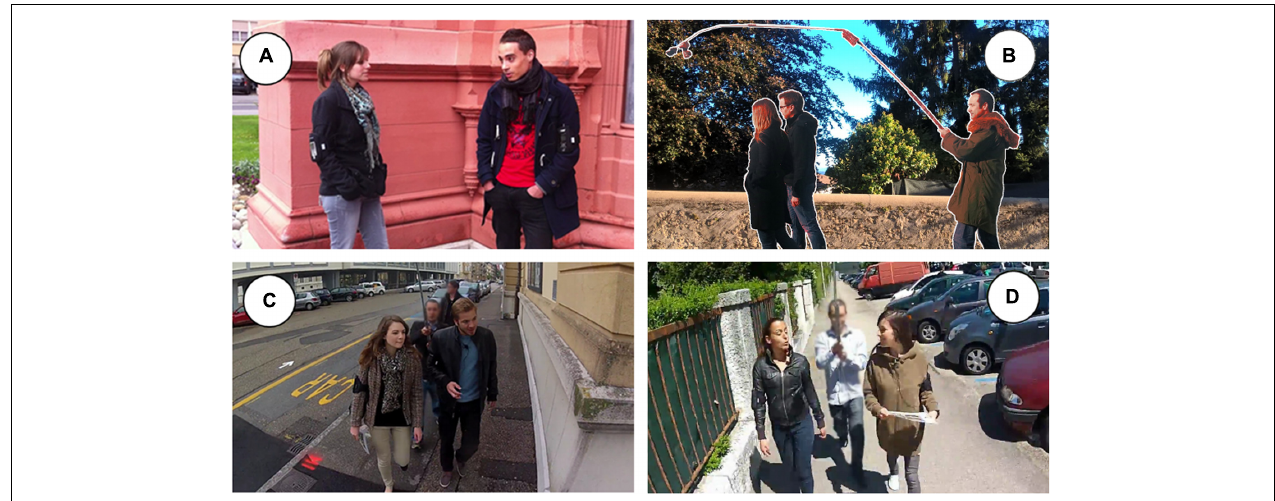
FIGURE 1 | (A) Talk-only condition. (B) Lateral view of the perch. (C) Talk-and-navigate condition, pair turning to their left. (D) Talk-and-navigate condition, pair engaged in mutual